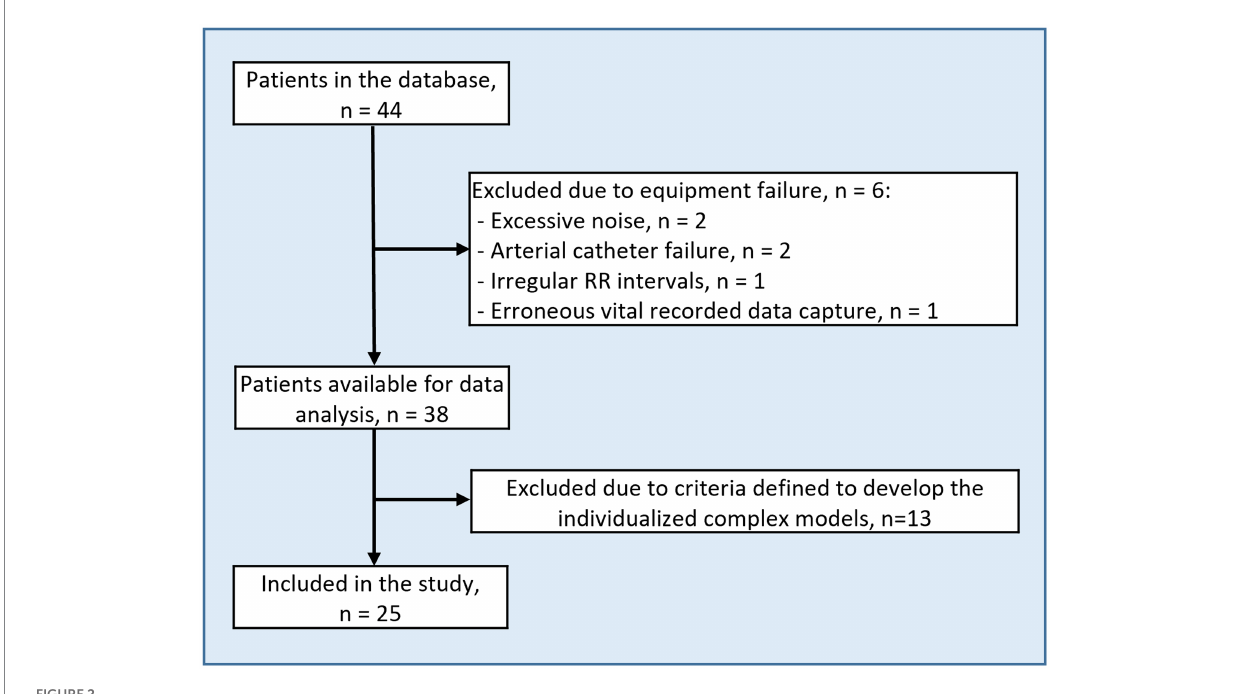
FIGURE 2 Flow chart of patient